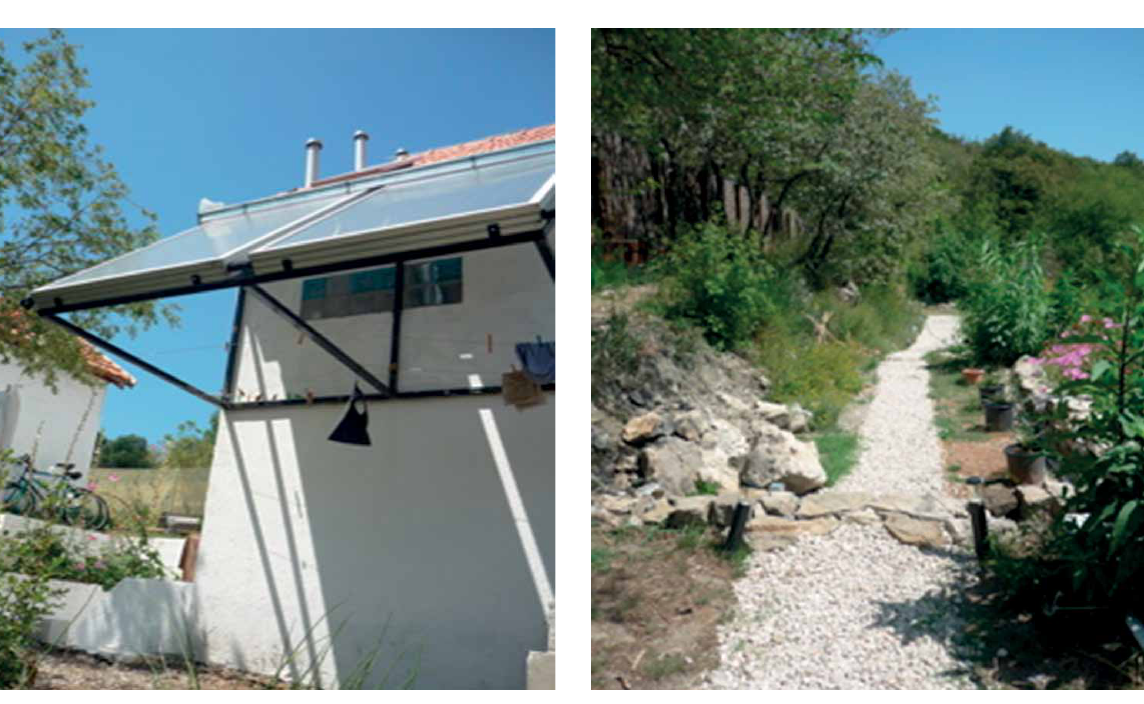
fig. 9. Electricity generated by PV panels fig. 10. Eco Camp Site